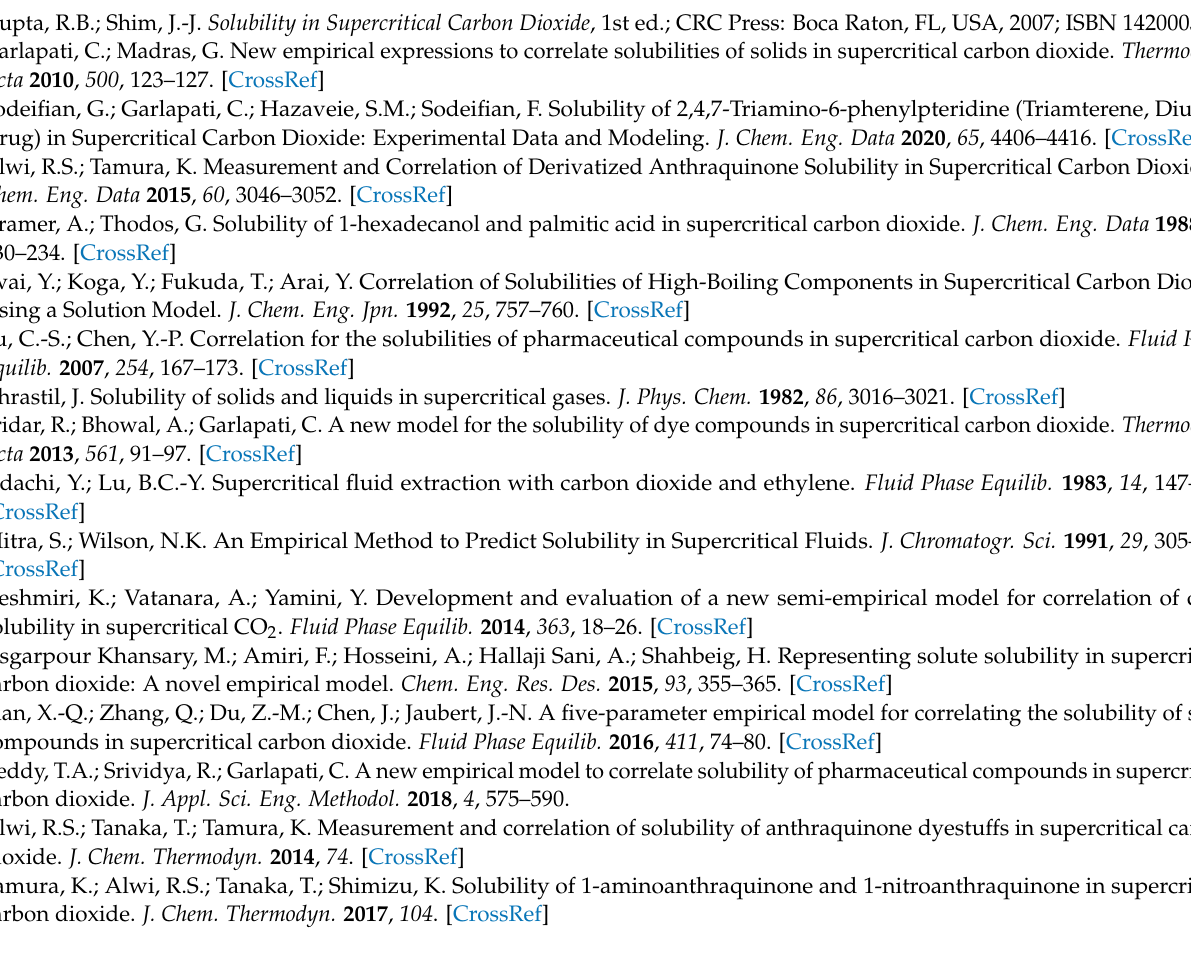
model, Table S7: Correlation Constants of Garlapati – Madras model, Table S8: Correlation Constants of Reddy et al.